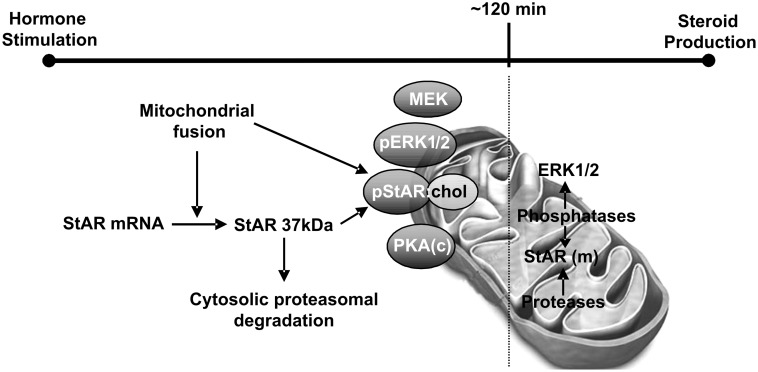
Summary of the proposed mechanisms for the association of StAR to the OMM in MA-10 Leydig cells following hormone stimulation.After hormone stimulation, mitochondrial fusion induction through Mfn2 up-regulation in mitochondria is needed for increasing StAR mRNA levels. Also, mitochondrial fusion is required post-transcriptionally for StAR localization at the OMM and subsequent binding to a cholesterol molecule. Then, cholesterol-bound StAR is available for ERK and PKA mitochondrial phosphorylation, increasing its activity and cholesterol transport. After the 2 h temporal frame of ERK activity, StAR is dephosphorylated, de-activated and translocated to the mitochondrial matrix where it is degraded by mitochondrial proteases. Abbreviations: pERK1/2 (phospho-ERK1/2), pStAR: chol (phospho-StAR bound to a cholesterol molecule), PKA(c) (PKA catalytic subunit), StAR (m) (StAR in the mitochondrial matrix).